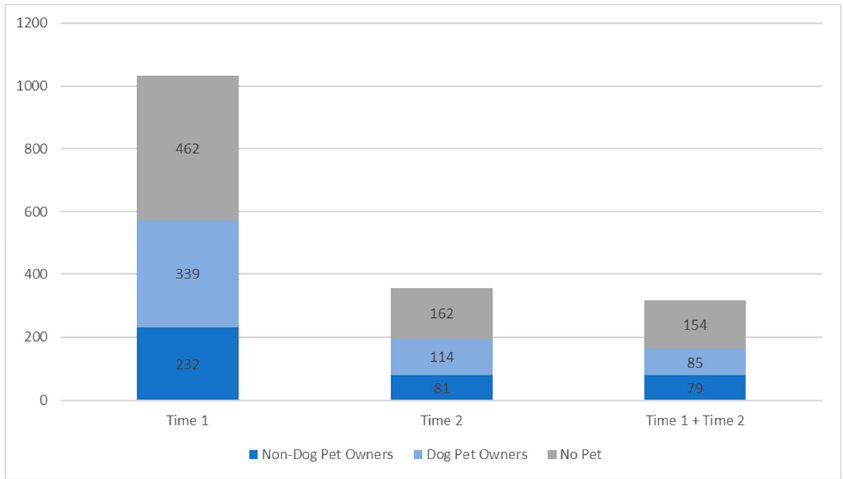
Figure 1. Proportion of pet owners for the cross-sectional samples (Time 1 only and Time 2 only) and for the longitudinal sample (Time 1 + 2).